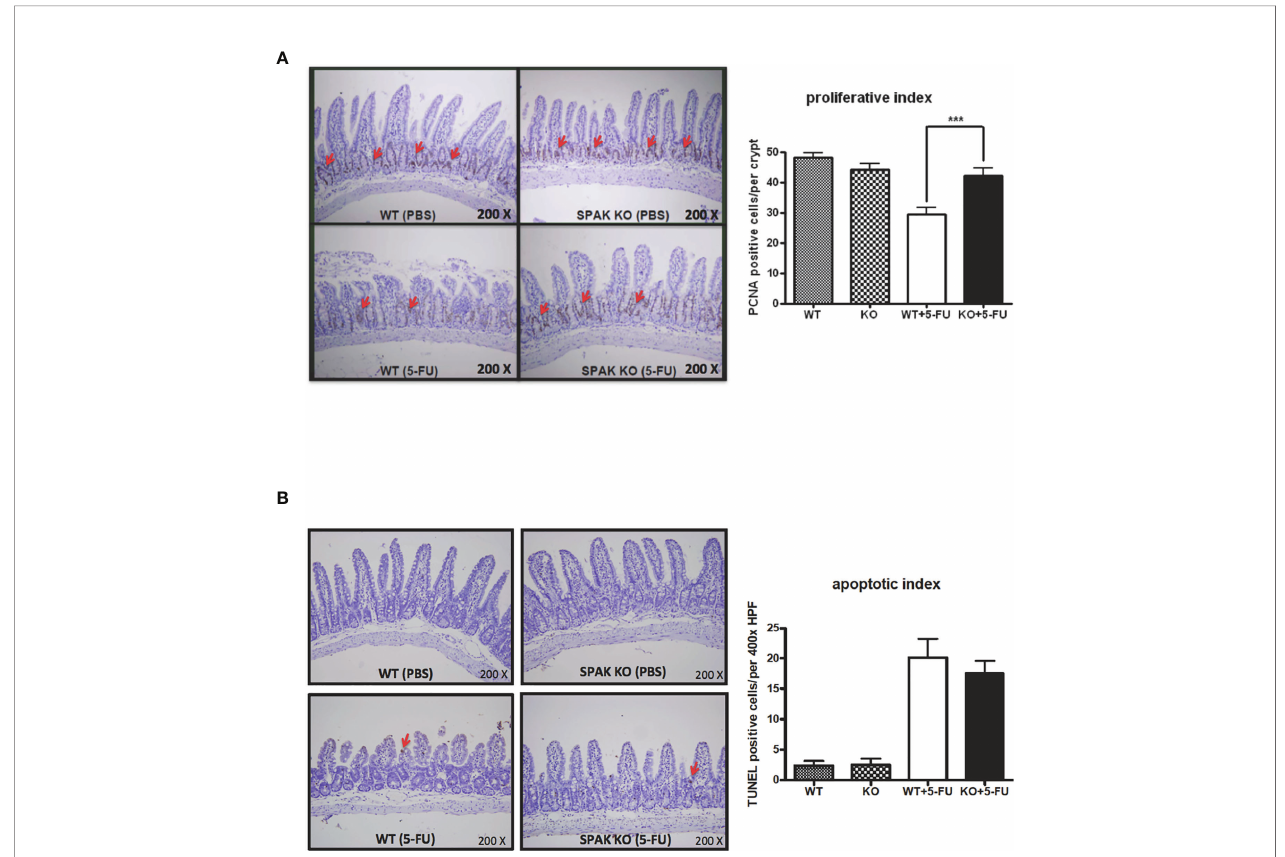
FIGURE 3 | Effects of SPAK on the proliferation and apoptosis of enterocytes in the small intestine of WT and SPAK-KO mice with 5-FU-induced intestinal mucositis. (A) Representative immunohistochemical staining of proliferating cell nuclear antigen (PCNA) in sections of the ileum is shown (the red arrows indicate positive cells, original magni fi cation: 200×). The proliferation index was de fi ned as the average number of PCNA-positive cells per crypt in 6 – 9 different microscopic fi elds observed at 400× magni fi cation in sections of the ileum (n = 3/group). (B) Representative terminal deoxynucleotidyl transferase dUTP nick-end labeling (TUNEL) assays of ileum sections are shown (the red arrows indicate positive cells, original magni fi cation: 200×). The apoptotic index was de fi ned as the average number of TUNEL-positive enterocytes per fi eld in 5 – 6 continuous microscopic fi elds observed at 400× magni fi cation in sections of distal ileal tissue from mice sacri fi ced on day 5 after 5-FU treatment (n = 3/group). Each bar represents the mean ± SEM; *** P < 0.001 represents signi fi cant differences between the indicated